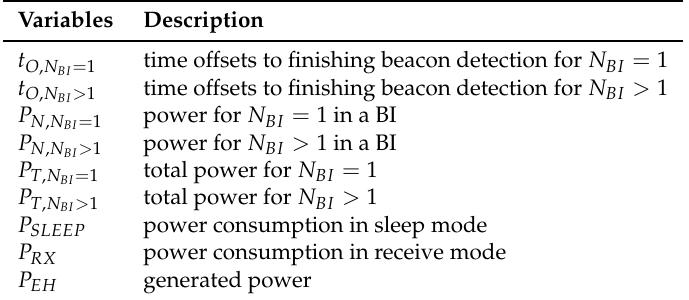
Table 1. Description of variables related to beacon detection